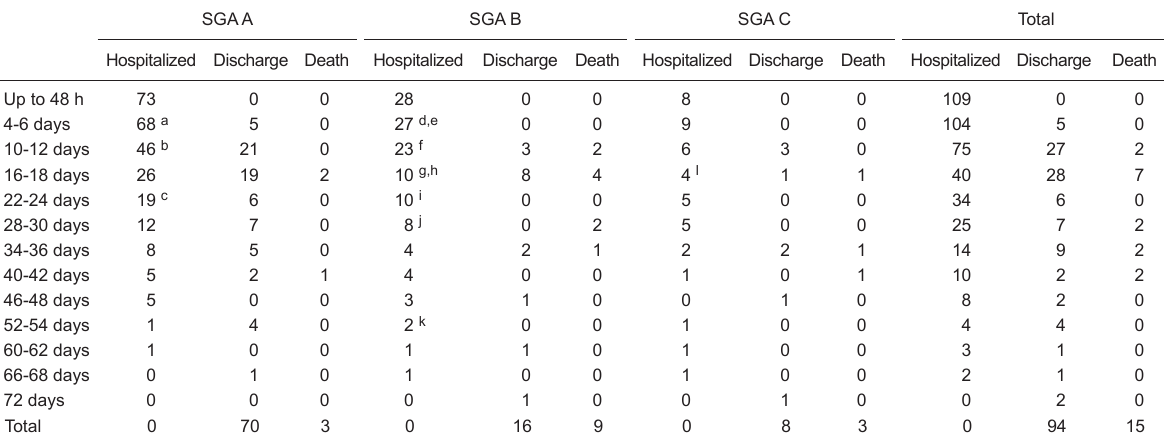
Table 3. Periodic assessment of nutritional status according to the Subjective Global Assessment (SGA) and clinical outcome of